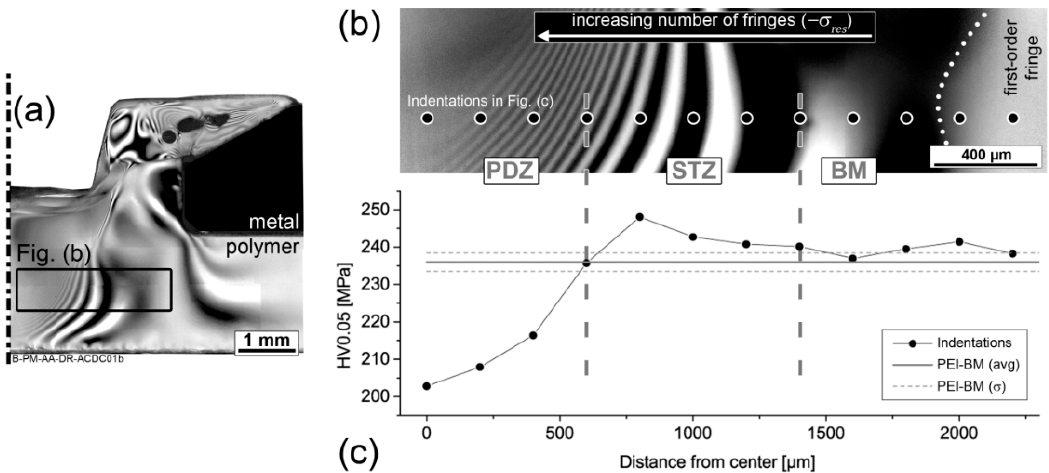
Figure 8. ( a ) Half of a cross-sectional view of a PEI-aluminum F-ICJ joint featuring a PDZ. ( b ) Birefringence of the PDZ-BM transition highlighted in ( a ), with number of fringes ( − σ res ) increasing in the PDZ direction (CP-TLOM). ( c ) Indentation profile highlighted in ( b ), showing the formation of a strengthened transition zone (STZ) between the PDZ and BM. The gray horizontal lines in ( c ) correspond to the PEI base material’s hardness. For processing conditions see Table 1. Adapted from [19].